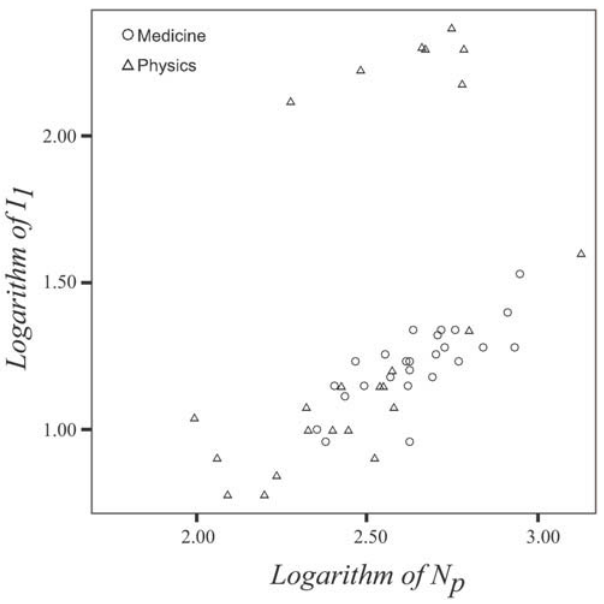
Figure 1. I 1 values as a function of the number of papers N p for selected highly-cited scientists in Clinical Medicine and Physics. Both axes are in log-10 scale.